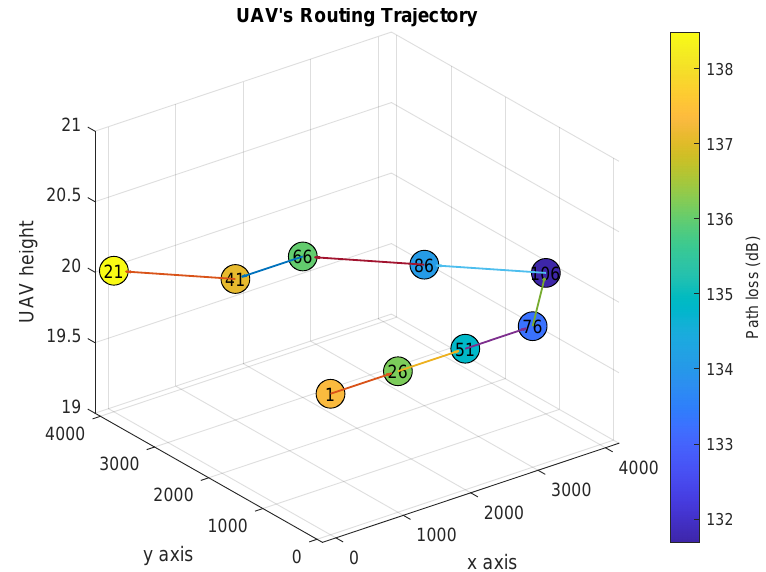
Figure 6. Optimal UAV’s trajectory design over the path loss map (Scenario